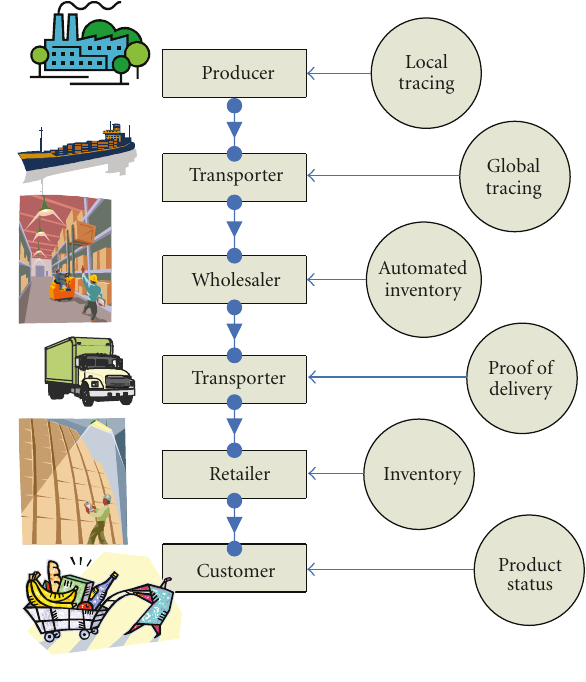
Figure 1: Logistics chain supervision.